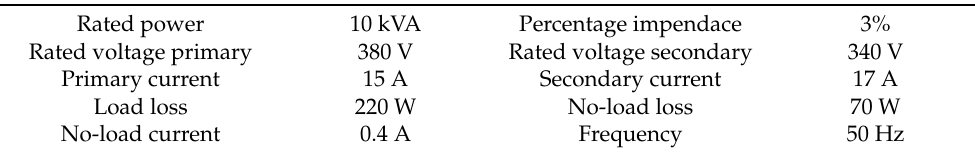
Figure 9. Equivalent diagram of the analyzed power system with division into structural elements. Table 2. Nominal data of three-phase power